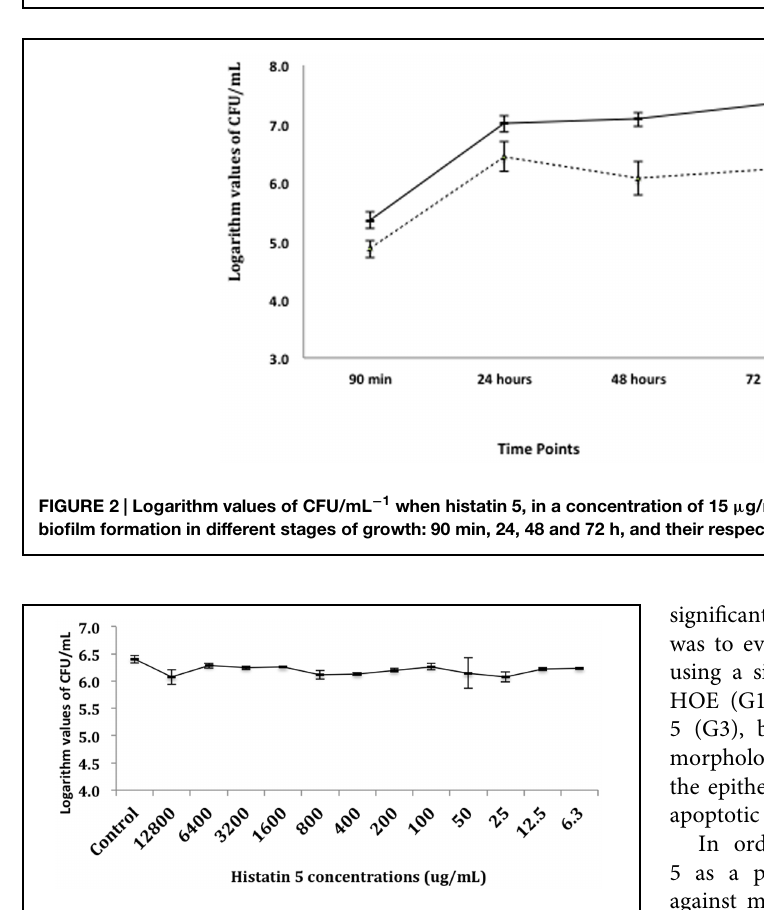
FIGURE 1 | Killing of Candida albicans by histatin 5. Cells were incubated for 1.5 h at 37 ◦ C with a dilution series of histatin 5 or without histatin 5 (control group). The dilutions were then plated in Sabouraud Dextrose Agar (SDA) media and the logarithm values of CFU/mL − 1 were calculated.